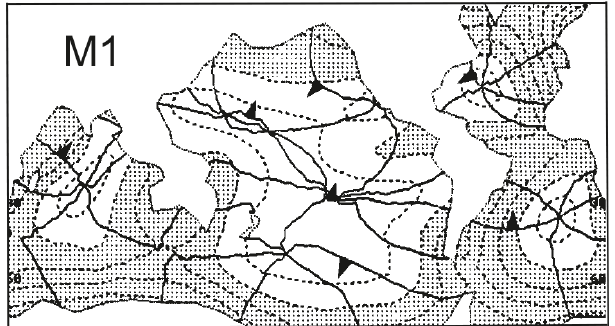
Figure 2. A map of the synthesized principal diurnal tide of third degree (M1). Amplitudes (dashed lines) are contoured at 1mm in- tervals, and are shaded where the amplitude exceeds 2mm. Phases are shown at 60 ◦ intervals, and the direction of phase propagation (increasing phase) is indicated by an arrowhead on contours of zero phase. This figure is copied from a panel in Fig. 9 of Platzman (1984b). Cartwright et al. (1988) had to add 60 ◦ to the phases shown here in order to adequately represent the tide gauge measurements of M1 phase, as shown for the Atlantic in Fig. 1; the reasons for the offset were not